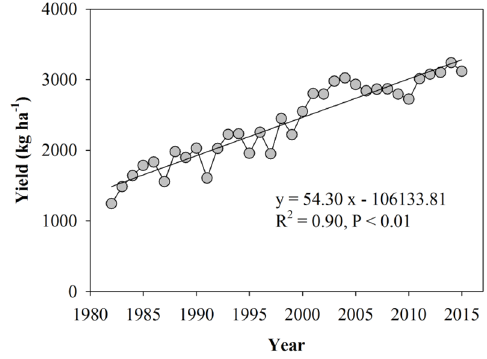
Figure 2. Changes in potato yields from 1982 to 2015 in northwest China.